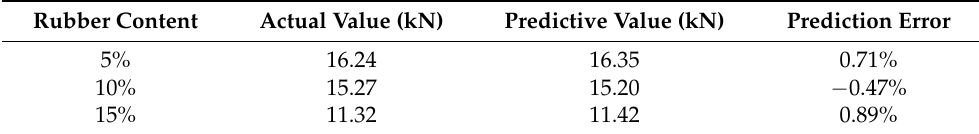
Table 15. Multiparameter neural network prediction